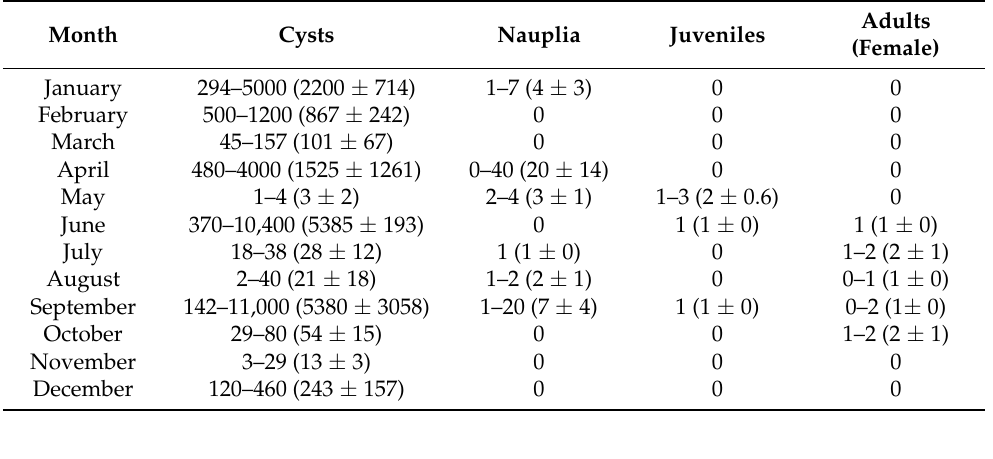
Table 2. Seasonal dynamics of the distribution and abundance of various ontogenetic stages of brine shrimp in the water of Saki Lake (spec./L, given in parentheses are averages ± SD of three to five determinations).